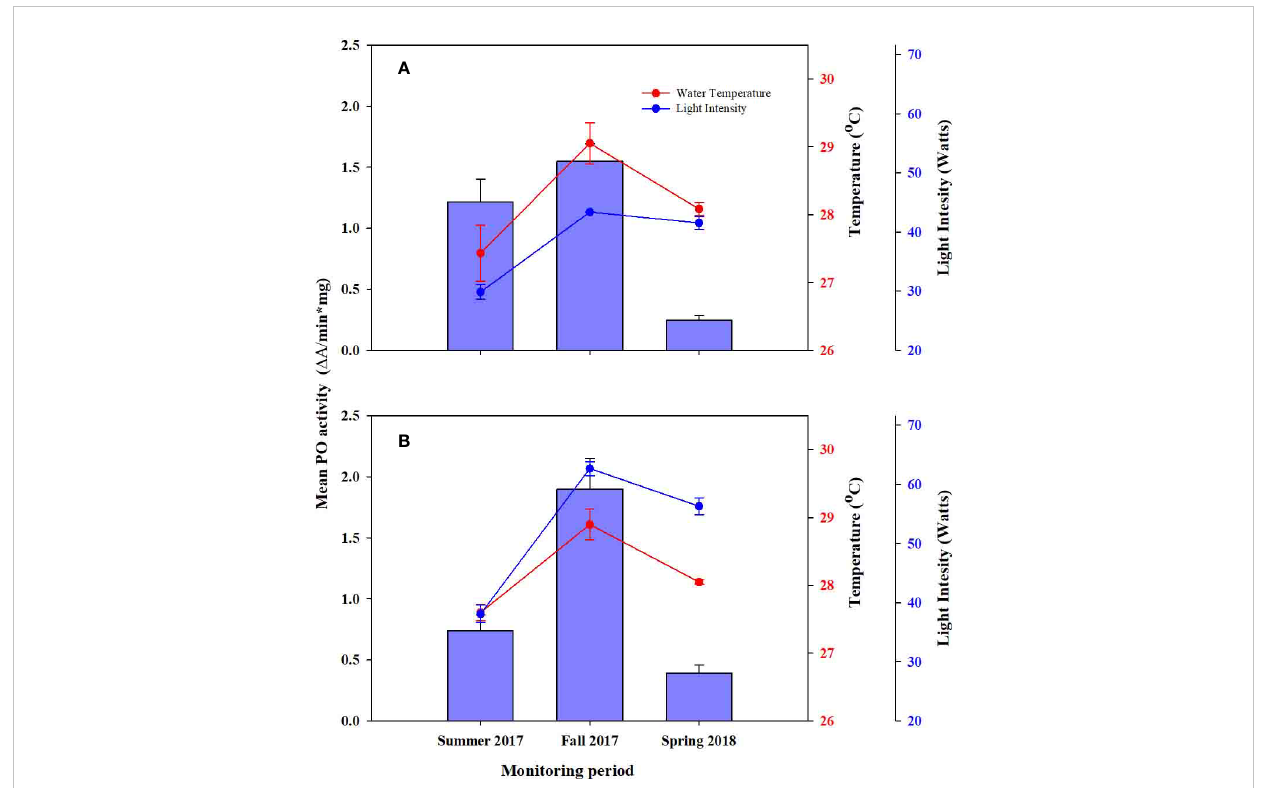
FIGURE 5 Comparison of Phenoloxidase (PO) activity across survey periods and, (A) Experimental colonies from deep farms (SD) and (B) experimental colonies from shallow farms (DS). Red and blue circles represent water temperature and light intensity. Whiskers represent standard